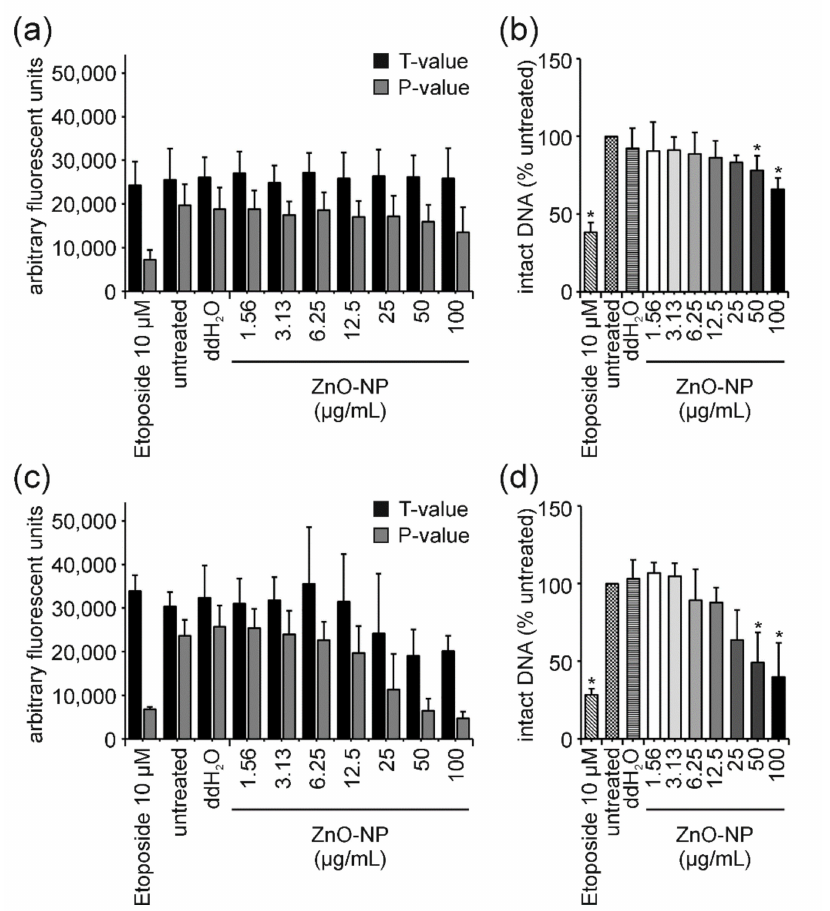
Figure 6. Influence of ZnO-NPs on T- and p -values in the FADU assay and corresponding inter- ference correction . Following 3 h ( a , b ) and 24 h ( c , d ) of exposure of Jurkat E6-I cells to ZnO-NP, the FADU assay was performed. After 3 h of incubation, only p -values decreased dose-dependently ( a ), while after 24 h, T- and p -values decreased with increasing ZnO-NP concentrations ( c ). Results following interference correction for the 3-h ( b ) and 24-h ( d ) time point are shown. Data shown repre- sent the mean of at least three independent experiments and the corresponding standard deviation. (* p ≤